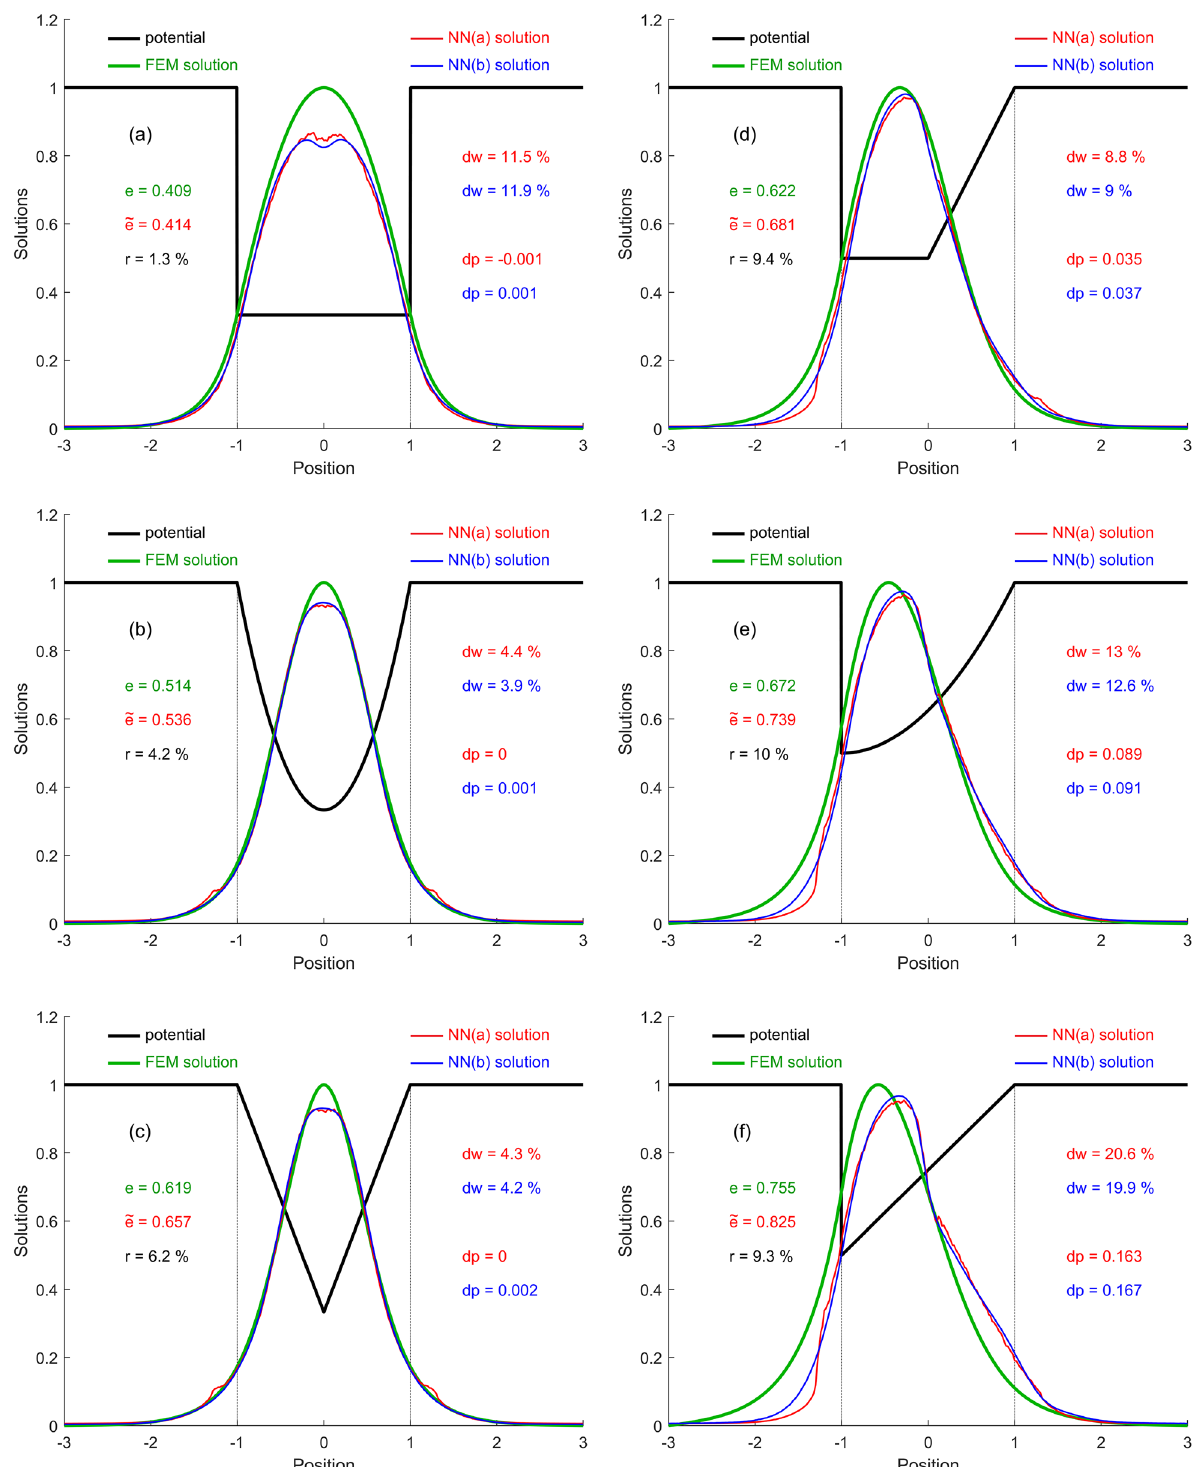
Figure 6. The FEM and NNs WF solutions and accuracy indicators in 8 particular cases with piecewise analytically-defined potential functions: ( a ) SQW; ( b ) PQW; ( c ) VQW; ( d ) TQW; ( e ) SPQW; ( f ) GQW; ( g ) LDQW; ( h )